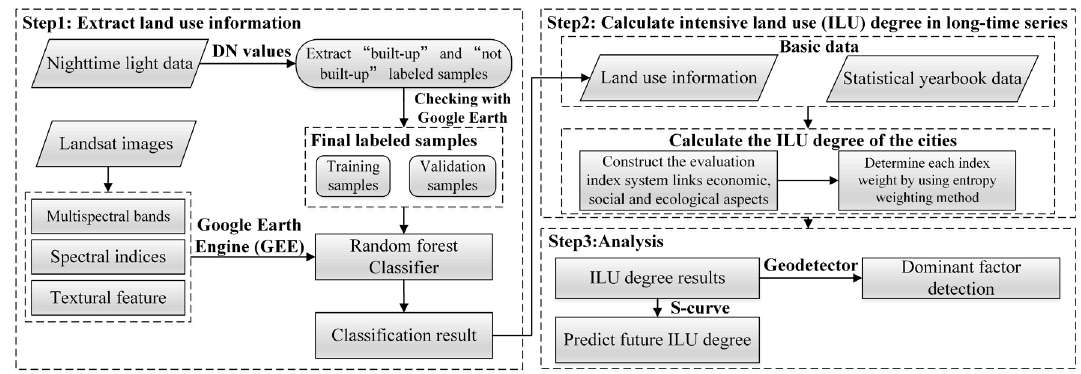
Figure 1. Research framework of this paper.